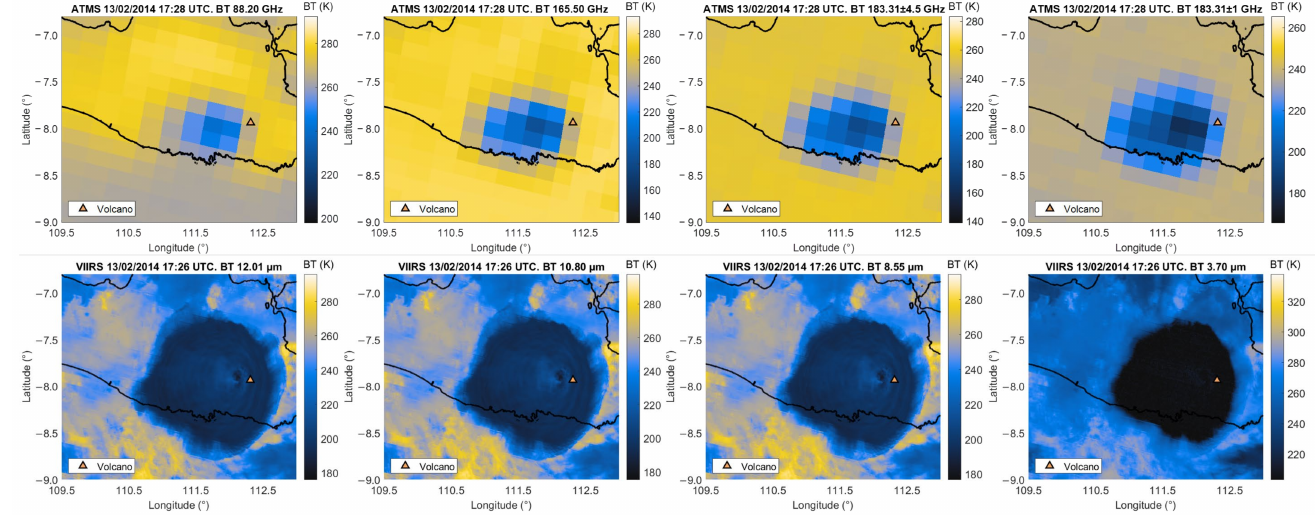
Figure 6. The Suomi-NPP Kelud eruption on 13th February 2014 at 17:26 UTC. ( First row ) ATMS brightness temperature at frequencies 88.20, 165.50, 183.31 ± 4.50 and 183.31 ± 1 GHz. Coldest pixels (blue and dark blue) highlight the volcanic cloud. ( Second row ) VIIRS brightness temperature at wavelengths 12.01, 10.80, 8.55 and 3.70 µ m. Dark blue and black pixels highlight the volcanic